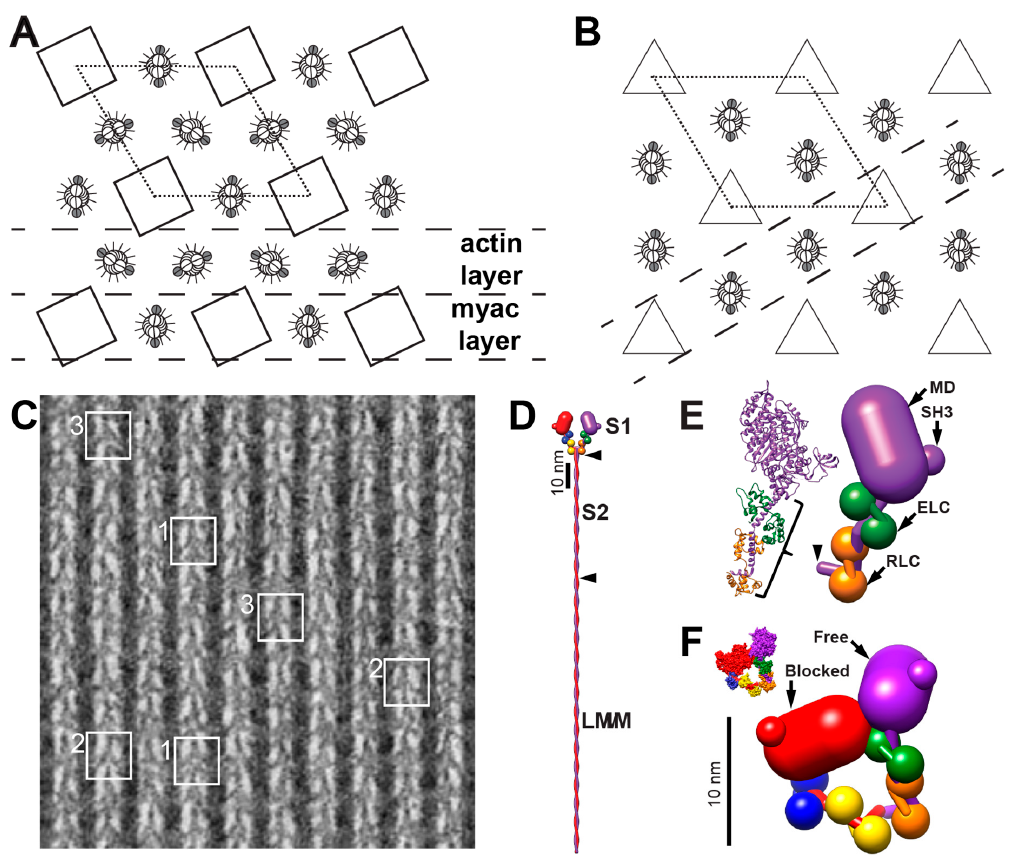
Figure 1. Introduction. ( A ) The filament lattice of the Lethocerus flight muscle. Thick filaments (squares) have four myosin molecules per 14.5 nm axial repeat (crown); crowns of individual filaments at any level are rotationally aligned. Thin filaments are placed midway between thick filaments with the troponin (Tn) complex oriented approximately perpendicular to the inter-filament axis of the hexagonal unit cell (dotted line). The filament placement permits two types of 25 nm section to be cut from the lattice: The actin layer containing only thin filaments and the myac layer containing alternating thick and thin filaments; ( B ) a simple vertebrate striated muscle lattice typically found in teleost fishes, has thick filaments, with three myosin molecules per 14.3 nm level placed at the corners of the unit cell (dotted line) but with thin filaments placed at trigonal positions [15]. The thin filaments are shown in rotational register consistent with observation [16]. No thin section comparable to those obtained from the Lethocerus flight muscle can be cut from the vertebrate striated muscle. The section closest in composition to a myac layer is marked with the dashed line. Note that, unlike the Lethocerus myac layer, myosin heads can approach the thin filaments from out-of-plane positions; ( C ) a myac layer thin section from rigor flight muscle. The myosin cross-bridges are distributed among classic double chevron motifs (white boxes labeled 1) consisting of paired lead bridges and paired rear bridges, single chevron motifs (white boxes labeled 2) consisting of only paired lead bridges and incomplete double chevrons (white boxes labeled 3) with a single rear bridge. Most descriptions of myosin head distribution in other states of the Lethocerus flight muscle are described as departures from the rigor double chevron motif; ( D ) schematic diagram of a myosin dimer with heavy chains colored red and purple. Paired myosin heads are positioned at the N-terminus of a ~160 nm coiled coil, the myosin rod, which can be proteolytically cleaved into a segment containing about 2/3 of the rod dubbed light meromyosin or LMM and a segment dubbed S2 containing the other 1/3; ( E ) the myosin head shown both as a ribbon diagram and schematically, containing a motor domain (MD, purple), essential light chain (ELC, green) and regulatory light chain (RLC, orange); ( F ) the Interacting Heads Motif (IHM) with the blocked head (red) positioned on the free head (purple). D–F from reference